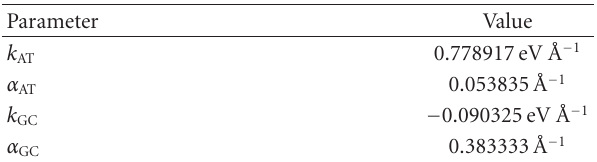
Table 2: Basic parameters for DNA molecules. The subscripts AT and GC for k and α denote the ones of the poly(dA)-poly(dT) and poly(dG)-poly(dC) DNA polymers, respectively. The other parameters are E 0 = 0 . 1eV, V 0 = 0 . 1eV, a = 3 . 4 ˚A, R 0 = 10 ˚A, and θ 0 = 36 ◦